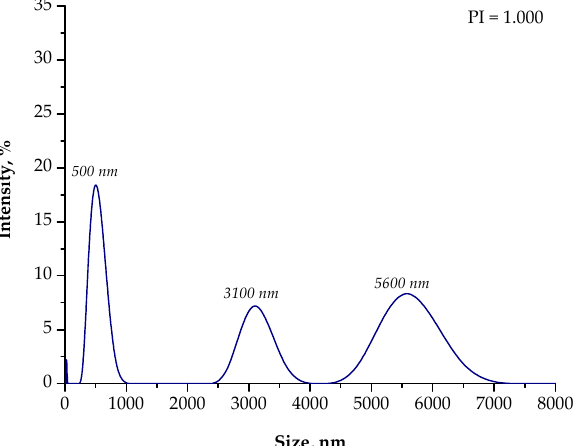
Figure 9. The size analysis of the Fe 3 O 4 @Ag particles obtained as a result of the synthesis performed using the 3% Arabic gum solution and the oil ( O ) reaction environment.